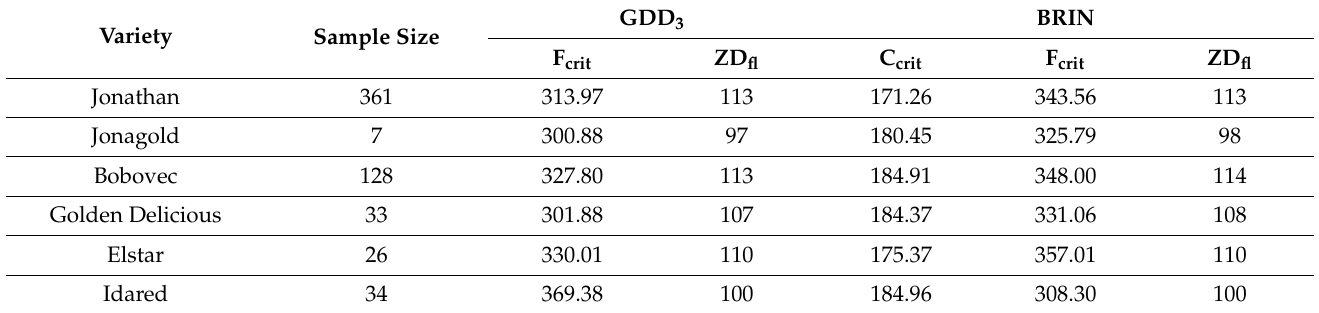
Table A3. Values of calculated parameter sets for several apple varieties and the two chosen pheno- logical models used in this analysis: GDD and BRIN (both with T b = 3 ◦ C).